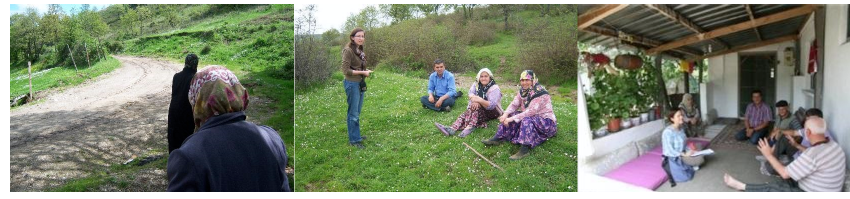
Figure 3 Interviews with local